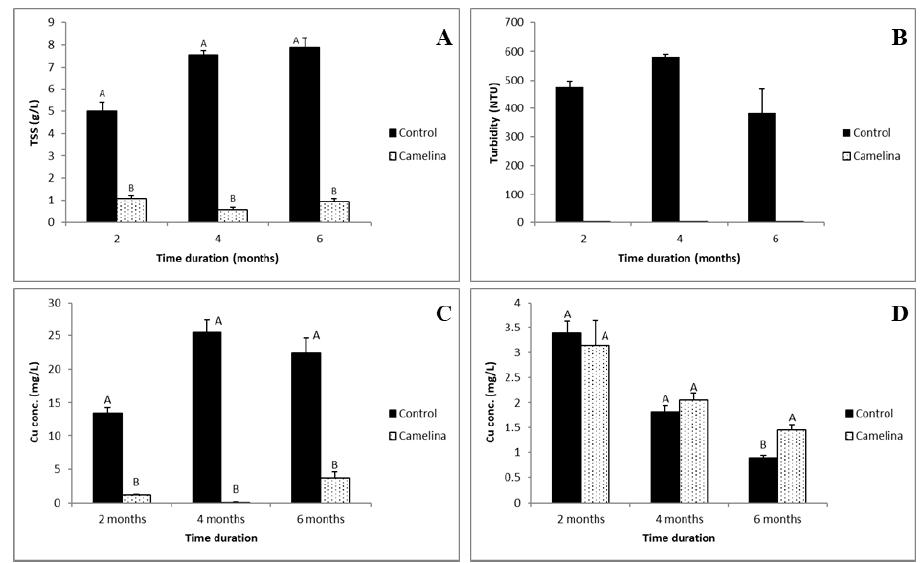
Figure 3. Top panel: Total Suspended Solids (TSS) ( A ) and turbidity (NTU) ( B ) in surface runoff in control and camelina panels. Bottom panel: Total Cu (mg/L) in runoff ( C ) and leachate ( D ) in control (no plant) and camelina panels during the study period. Data are reported as mean ( n = 3) ± S.D. Means are compared by Tukey Kramer-HSD test ( α = 0.05). The treatment levels that are not connected by the same letter are significantly different from each other.